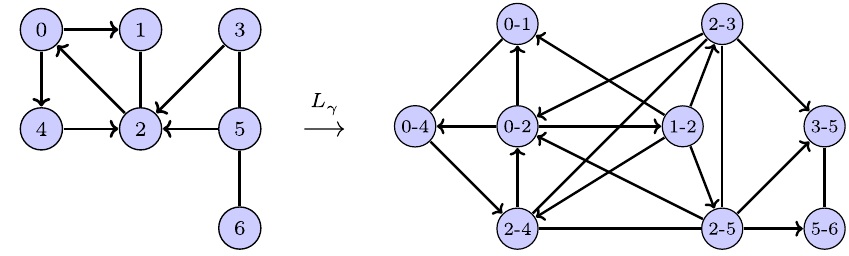
Figure 2: γ - line graph